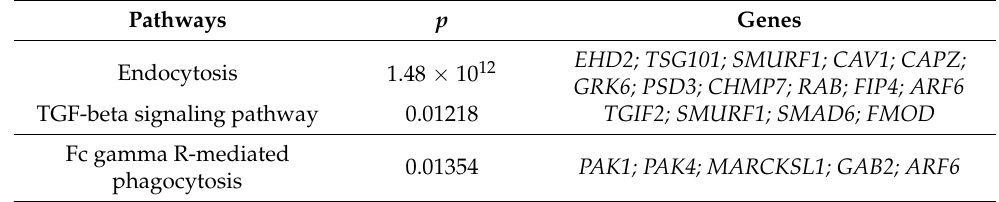
Table 5. Main pathways regulated by miR-612.